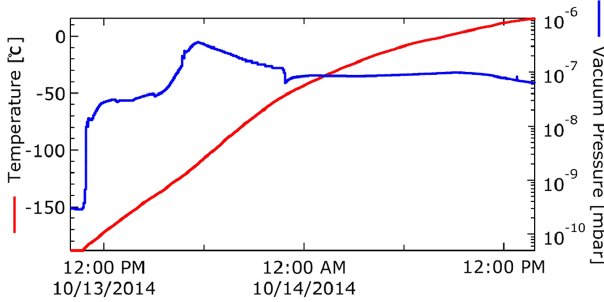
FIG. 14. (a) Phase error corrections with rod vertical displace- ment at minimum gap of 5.5 mm. (b) Phase error variation versus gap after